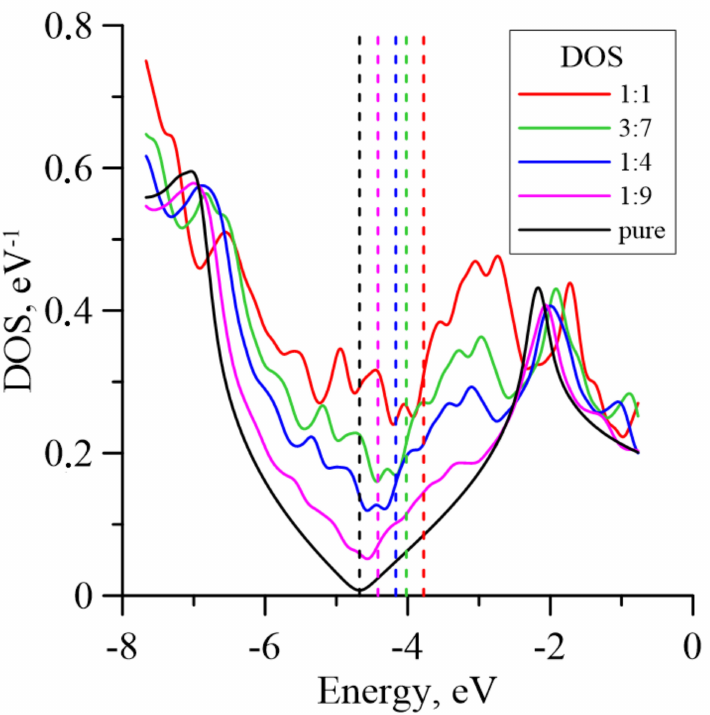
Figure 3. DOS curves for pure graphene and G/Fe 3 O 4 membrane nanofilms with different concen- trations of magnetite particles. The dotted lines correspond to Fermi